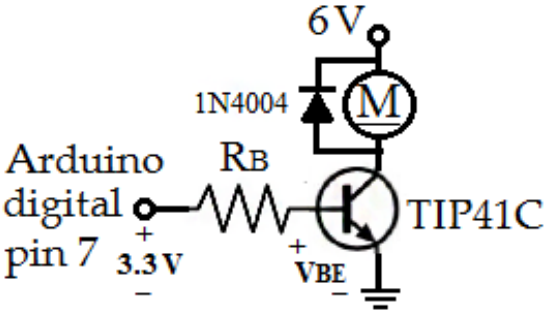
Figure 3. Trigger circuit for vacuum pump.